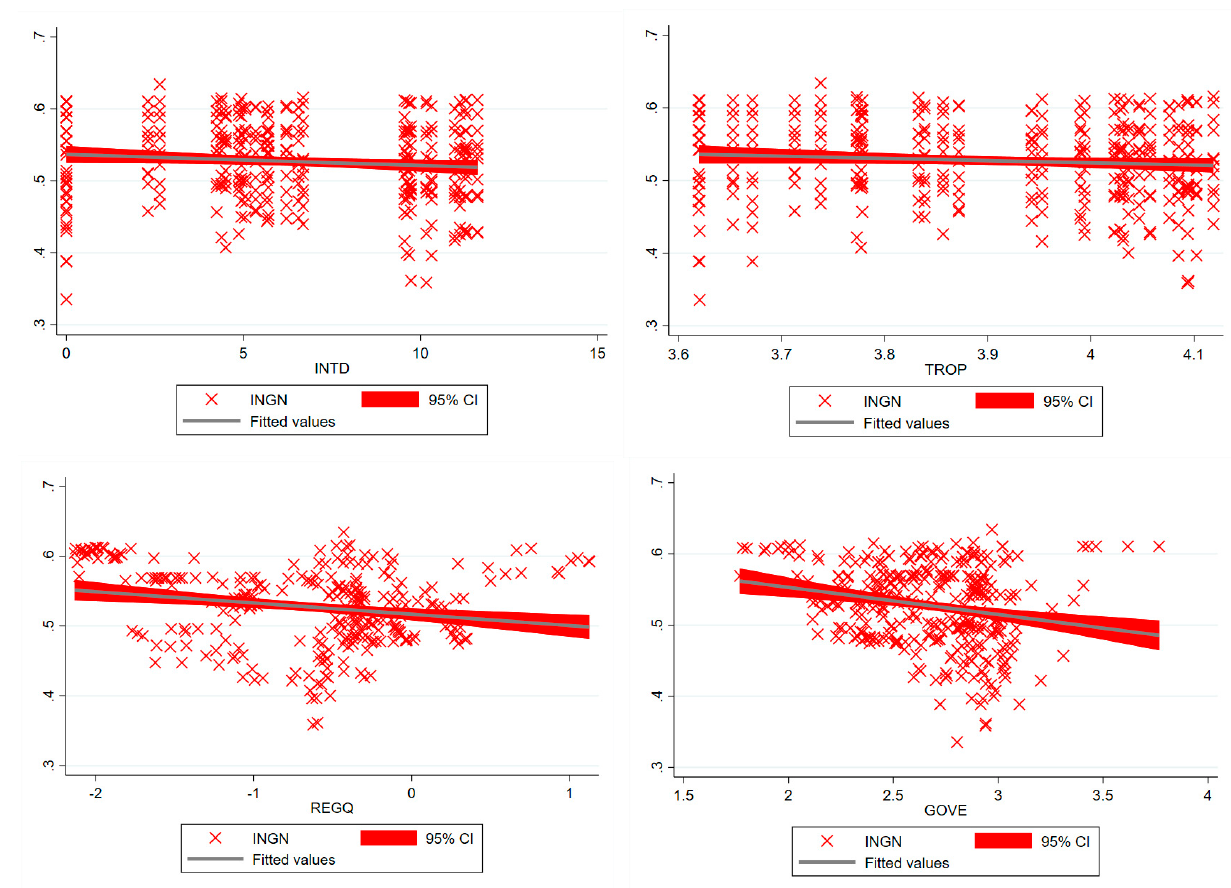
Figure 5. Fi tt ed values for income inequality and globalization dynamics. Note: CI—Con fi dence interval. Legend: INGN—Income inequality Gini coe ffi cient, INTD—Global internet di ff usions; interval. Legend: INGN—Income inequality Gini coefficient, INTD—Global internet diffusions; TROP—Global trade openness. TROP—Global trade